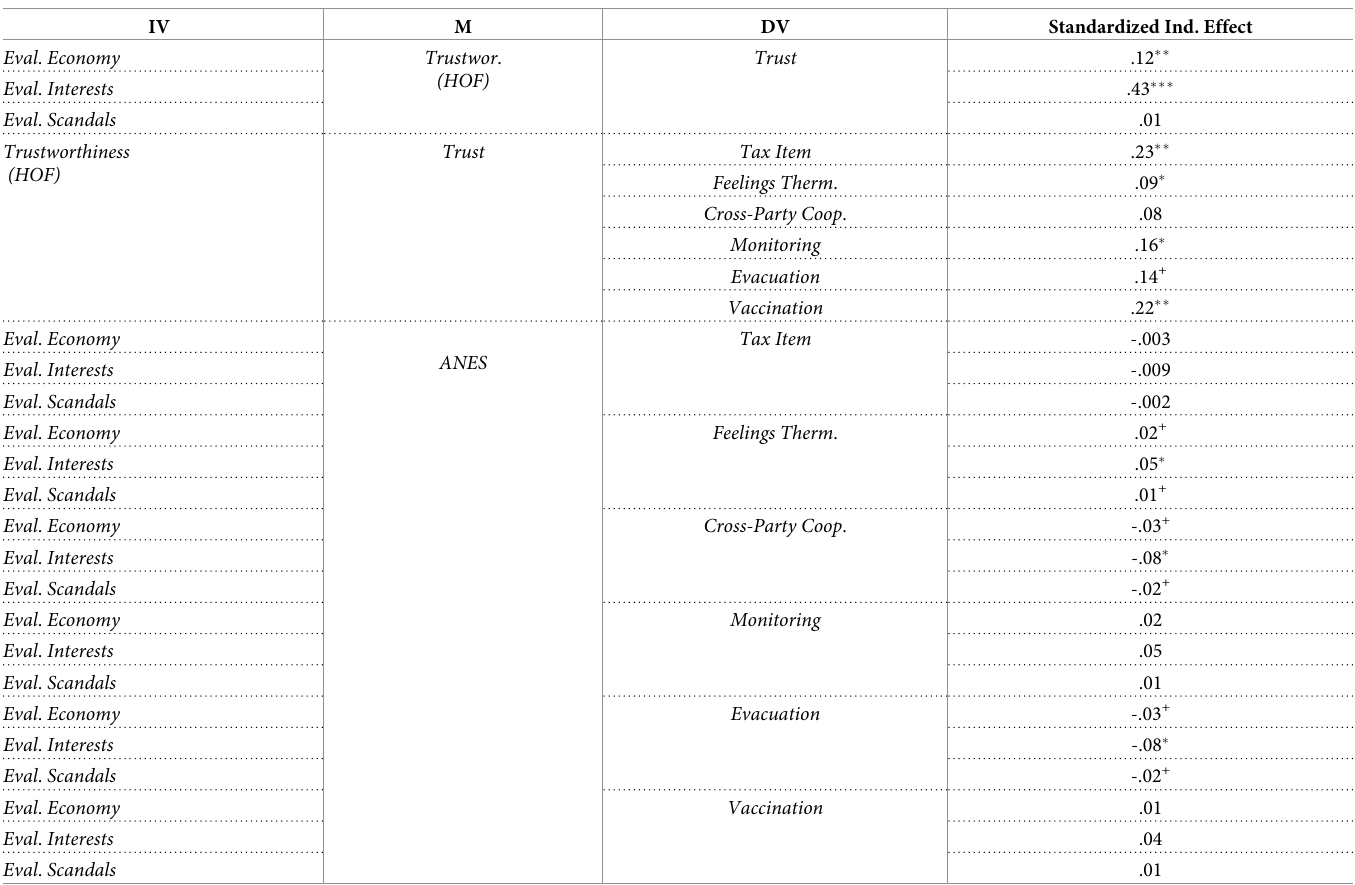
Table 6. Summary of indirect